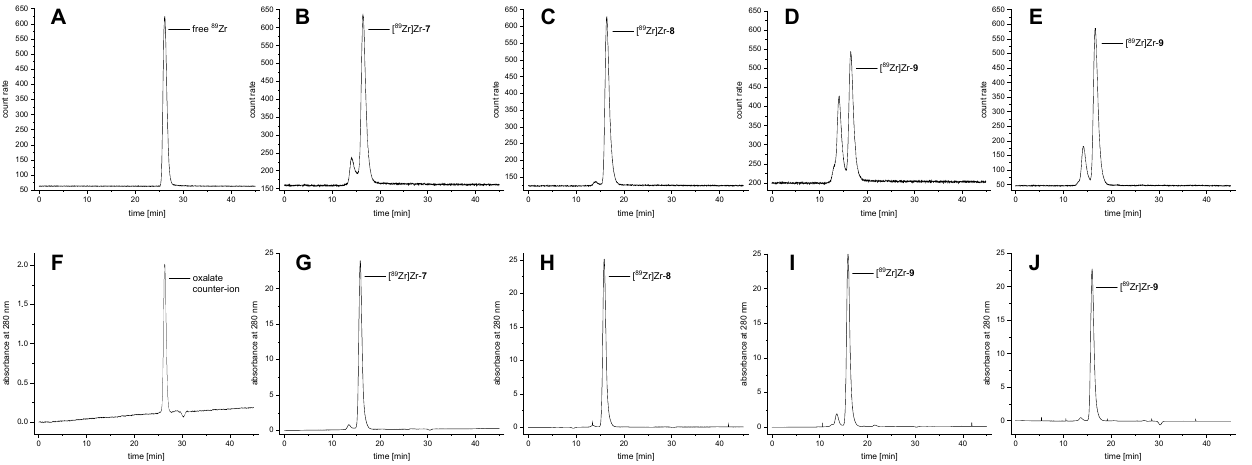
Figure 4. Analytical size-exclusion radio-HPLC chromatograms of [ 89 Zr]Zr-oxalate (as reference) and the labeled antibodies [ 89 Zr]Zr- 7 –[ 89 Zr]Zr- 9 . Radio-traces are depicted in panel ( A – E ) and corresponding UV traces in panels ( F – J ). Depicted are chromatograms of [ 89 Zr]Zr-oxalate ( A , F ), [ 89 Zr]Zr- 7 ( B , G ), [ 89 Zr]Zr- 8 ( C , H ), [ 89 Zr]Zr- 9 , labeled with 50 MBq/mg protein ( D , I ) and [ 89 Zr]Zr- 9 , labeled with 25 MBq/mg protein ( E , J ).